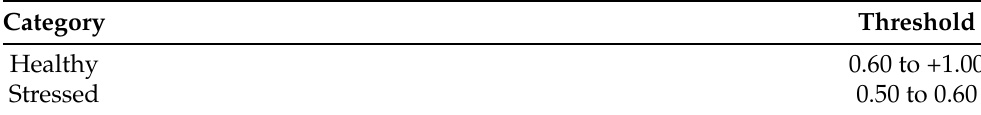
Table 5. Level-3b classification of trees region into stressed and healthy regions.